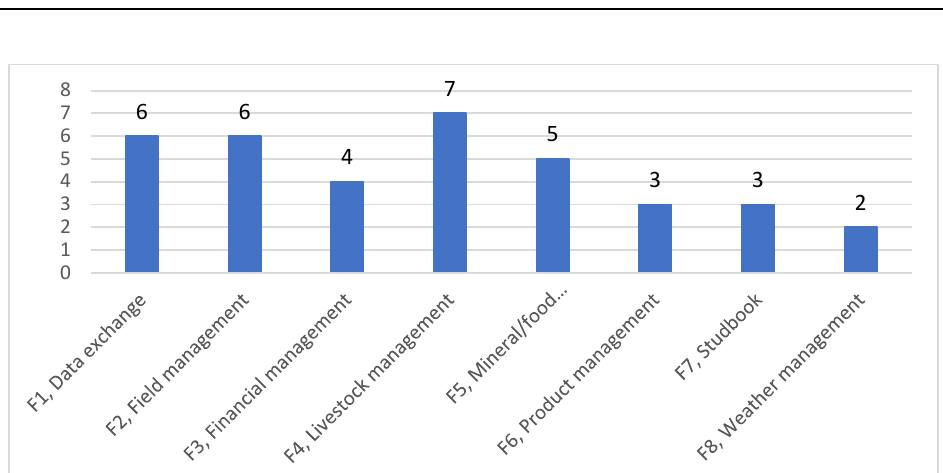
Table 4. Codes for the specified fields of focus for an FMIS.